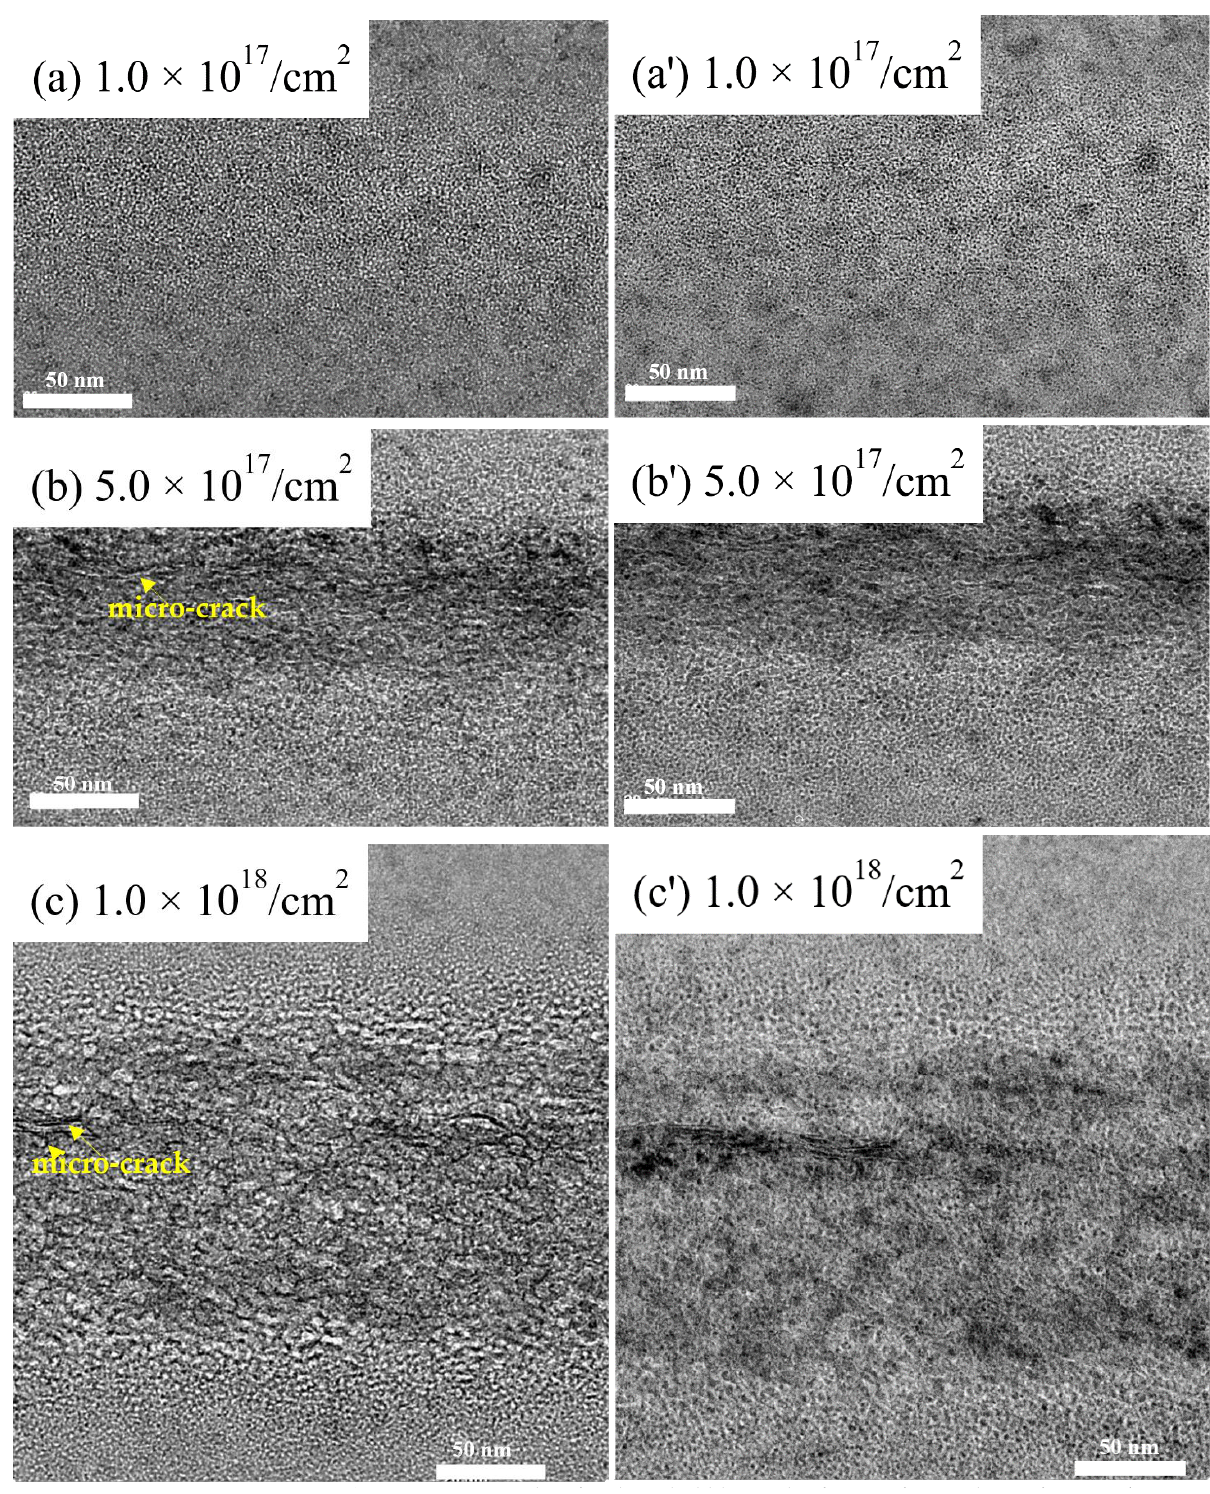
Figure 6. TEM graphs of Helium bubbles under focus ( a , b , c ) and over focus ( a’ , b’ , c’ ) in the damage peak zones of samples implanted to ( a , a’ ) 1.0 × 10 17 ions/cm 2 , ( b , b’ ) 5.0 × 10 17 ions/cm 2 , and ( c , c’ ) 1.0 × 10 18 ions/cm 2 .